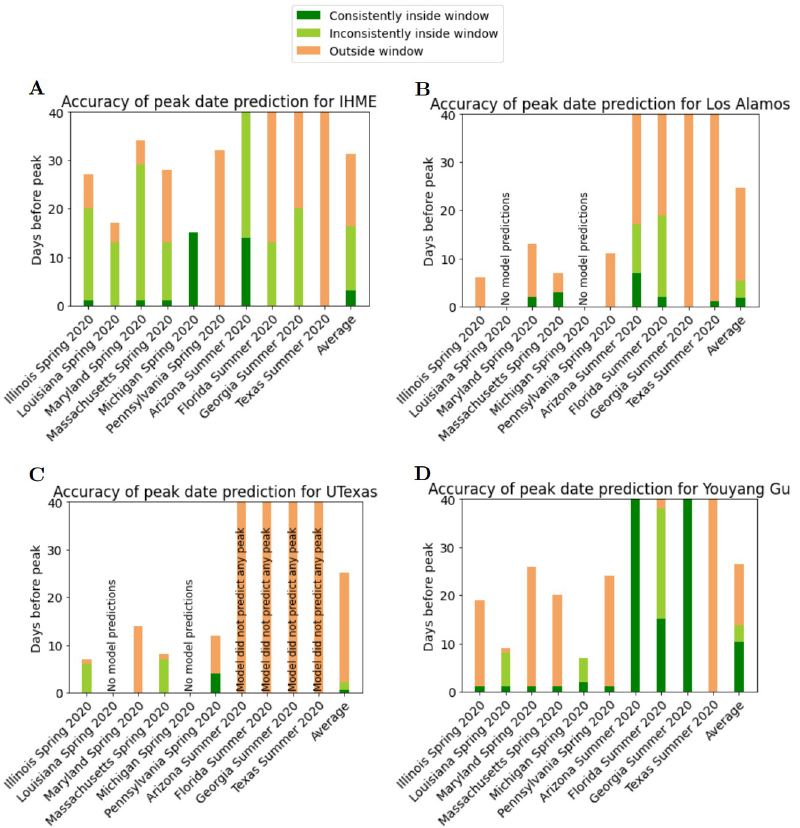
Fig 7. Visualization of predictive accuracy for date of peak deaths of all Spring and Summer 2020 death peak events (see Table 2). A) IHME, B) Los Alamos, C) UTexas, and D) YYG. Each bar represents a peak event. Dark green region represents the days prior to peak that the model accurately and consistently predicted date of peak (see definition of PeakDate_FirstConsistent score). Orange/light green boundary represents first day model predicted date of peak (see definition of PeakDate_FirstAccurate